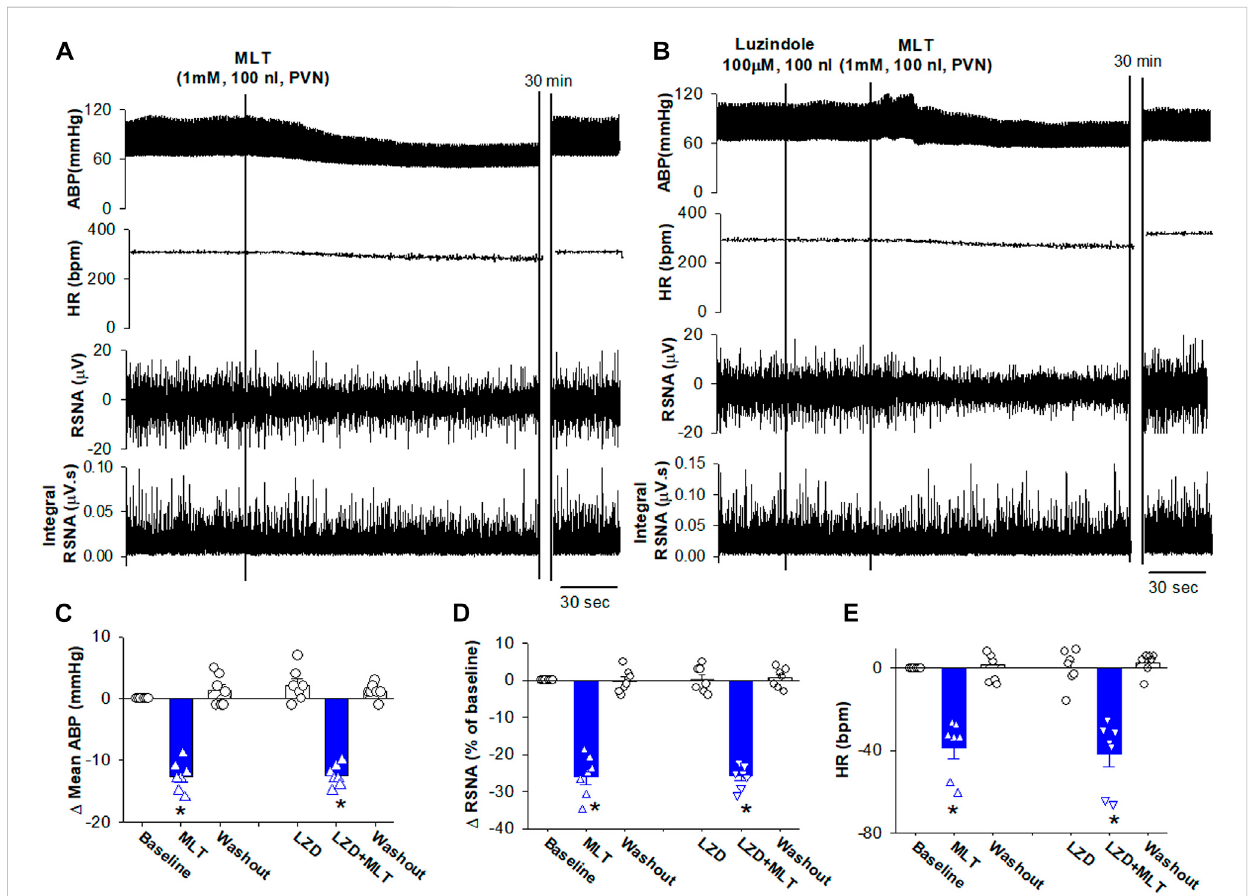
Microinjection of melatonin into the PVN reduced ABP and sympathetic out fl ow. (A) , Representative recordings show that the effect of bilateral microinjectionofmelatonin(0.1 mM,100 nL)intothePVNonmeanABP,RSNA,HR,andintegratedRSNA(Int-RSNA). (B) ,Representativerecordingsshow microinjectionof non-selective antagonist luzindole (10 mM,100 nL) failed to alter themelatonin-induced reduction of ABP and RSNA. (C – E) , Summary data show change of mean ABP, RSNA, and HR in response to microinjection of melatonin and luzindole, an antagonist for MT1 and MT2